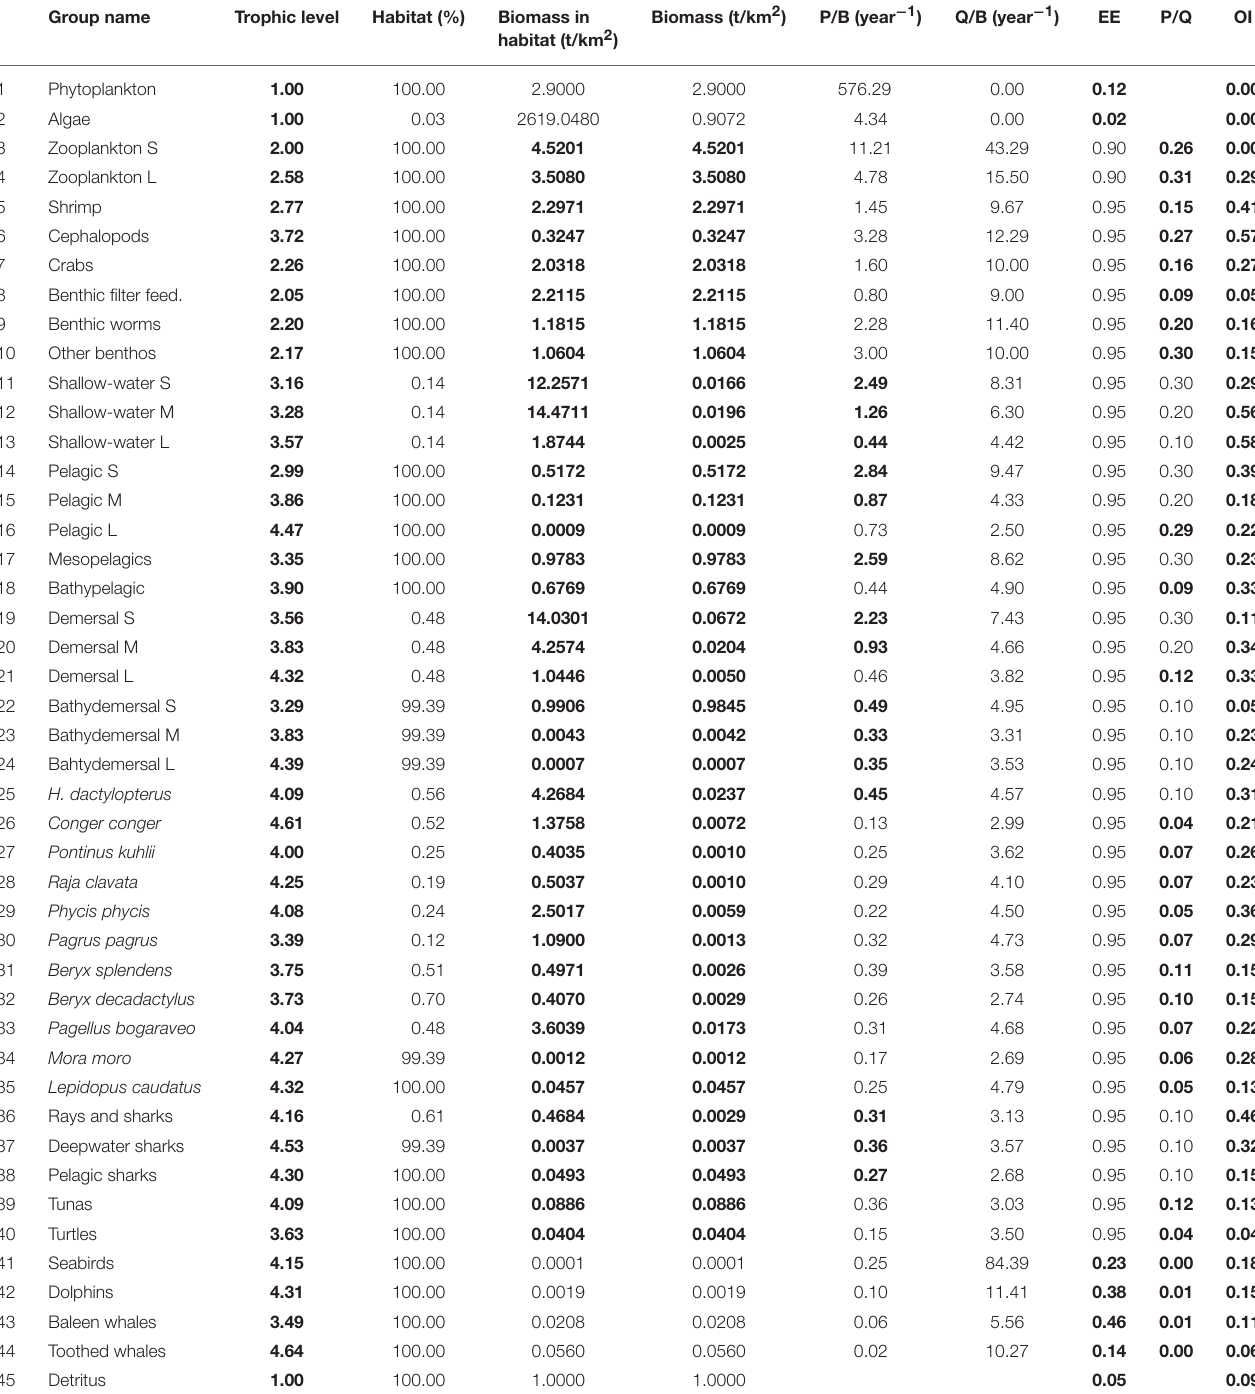
TABLE 1 | Input parameters for Azores ecosystem model showing those estimated by the model in